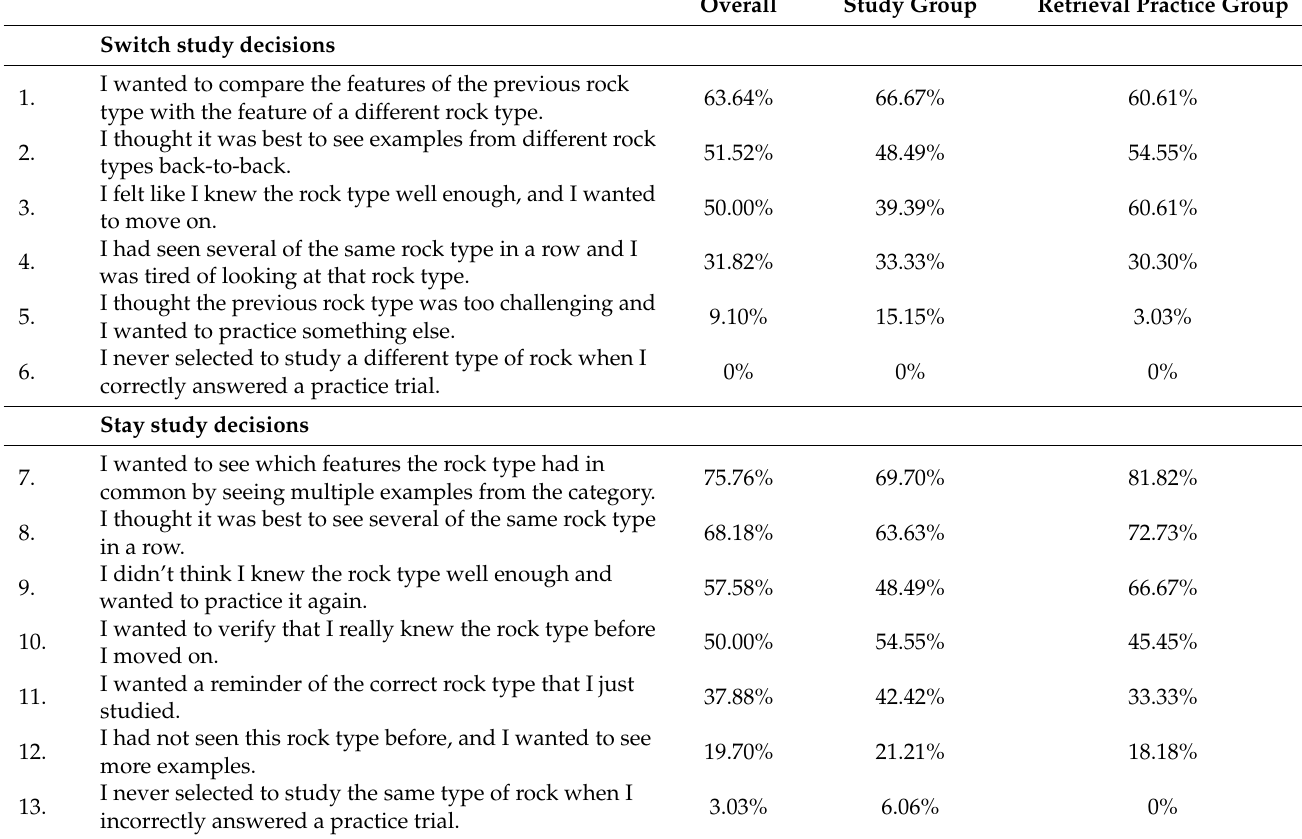
Table 3. Students’ Responses about their Study